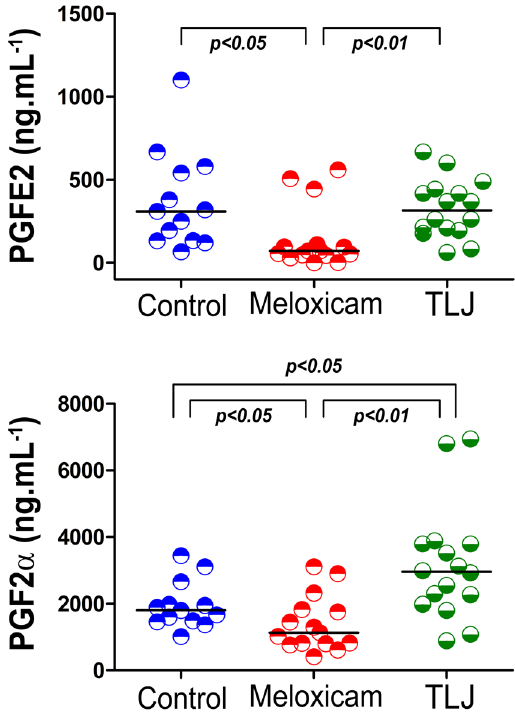
Figure 5. Demonstration of the augmentation of concentration of PGF2 α in the menstrual fluid of women that consumed TLJ at the beginning of the menstrual phase. Scatter Plot showing the individual values and the median of the F2 α and E2 Prostaglandins concentrations (ng.mL − 1 ) present in the menstrual serum from the Control (n = 13), Meloxicam (n = 15) and TLJ volunteers (n = 16), collected on the second day after the beginning of the menstruation cycle. The PGE2 was analyzed by the Kruskal-Wallis and Dunn’s statistical tests for multiple comparisons and the data from PGF2 α was log transformed and analyzed by ANOVA and the Newman-Keuls statistic test for multiple comparisons.